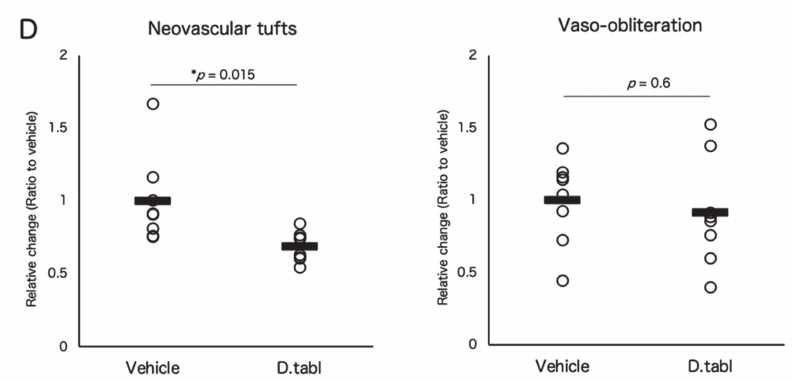
Figure 5. Oral administration of Decapterus tabl ingredient suppress retinal neovascularization in a murine oxygen-induced retinopathy (OIR) model. ( A ) Schematic illustration of the OIR procedure. Vehicle or D. tabl was orally administered from P12 to P16. ( B ) Mean body weight change of mice. The average body weight of the D. tabl group did not di ff er from that of the vehicle group throughout the administration period. ( C ) Representative images of retinal vasculature staining with isolectin B4. Areas of neovascular tufts (red) or vaso-obliteration (yellow) are highlighted. ( D ) Quantification of neovascular tufts (left) and vaso-obliteration (right) in OIR as a percent of the total retinal areas. Note that D. tabl significantly ( p < 0.05) suppressed neovascular tufts, while no significant di ff erence was observed in vaso-obliteration. n = 4 / group. * p < 0.05; n.s., not significant. Error bars indicate mean plus